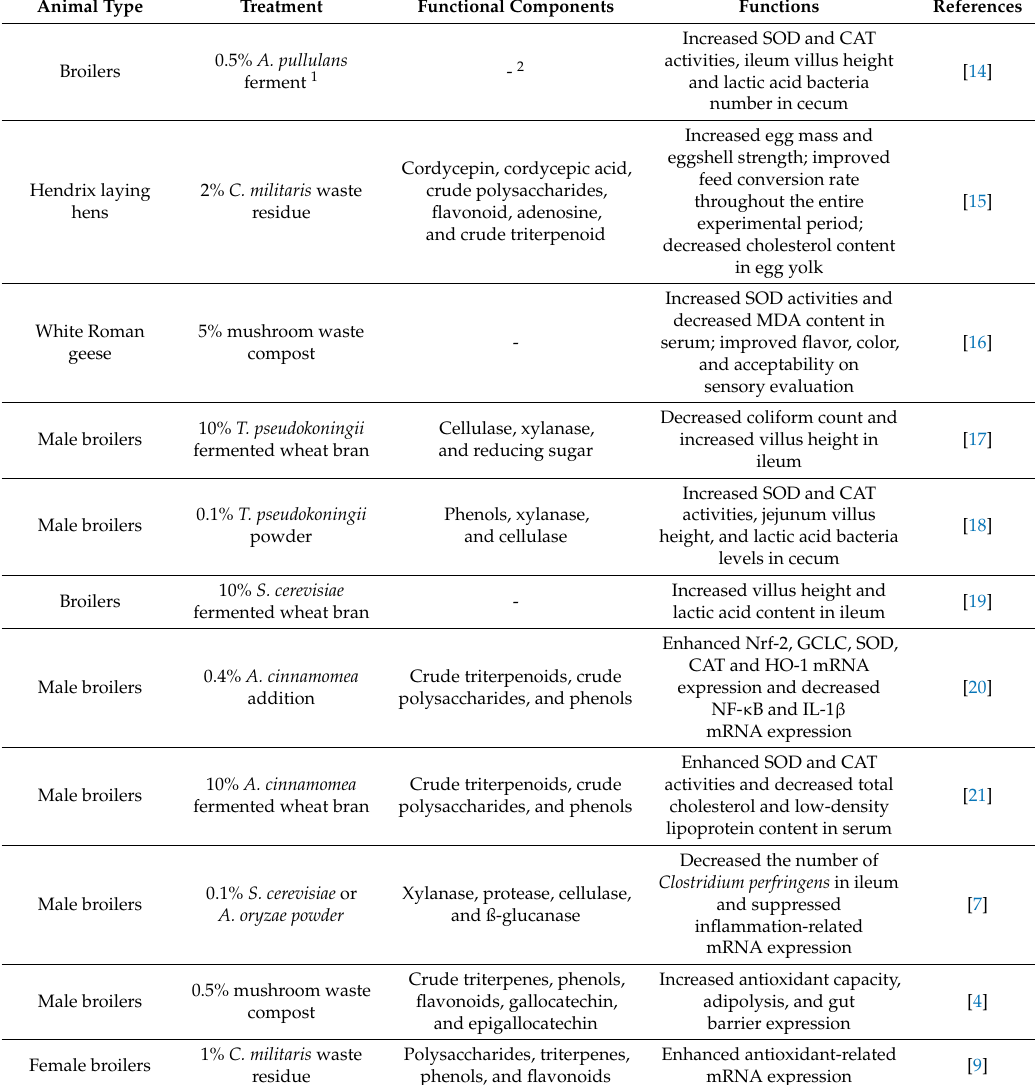
Table 2. The e ff ects of fungal feed additives on animal